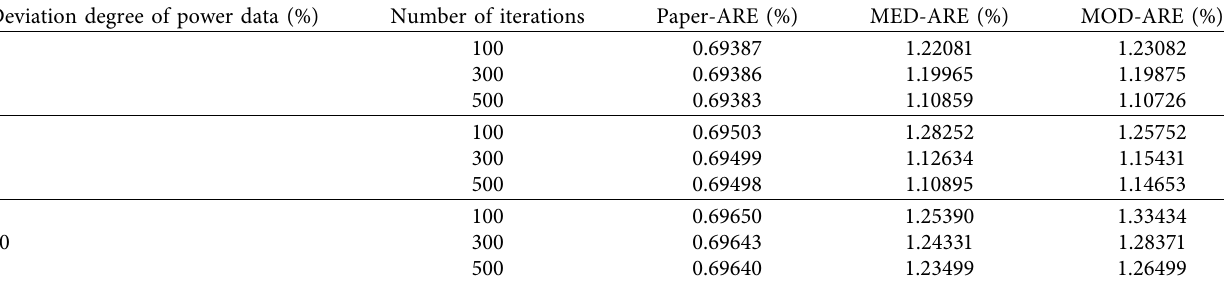
Table 5: Antinoise ability of algorithm (power noise).